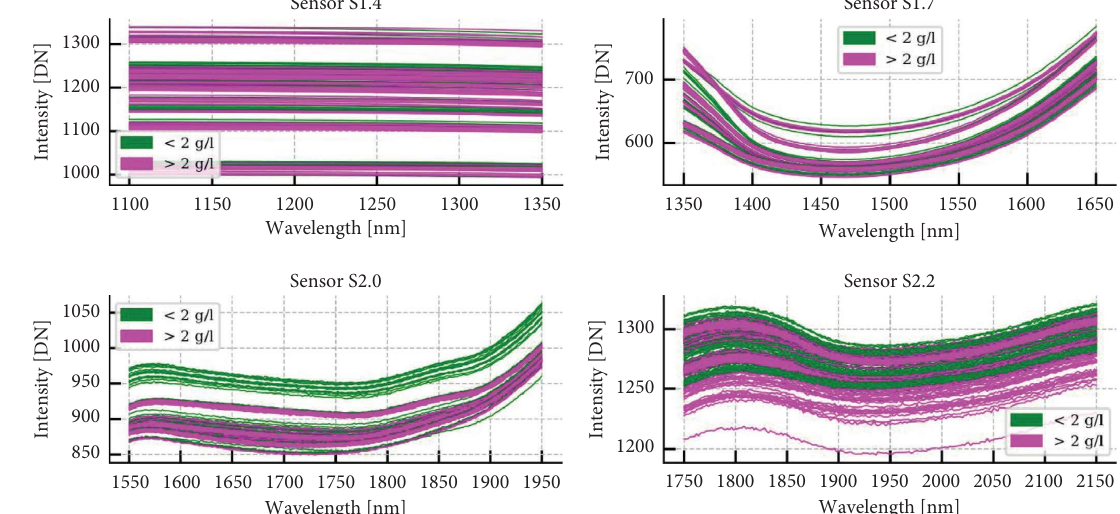
Figure 4: Diagram based on classes for a wavelength range of 1100 to 2150nm. Table 2: Te MNR of the sensors. NIR sensor